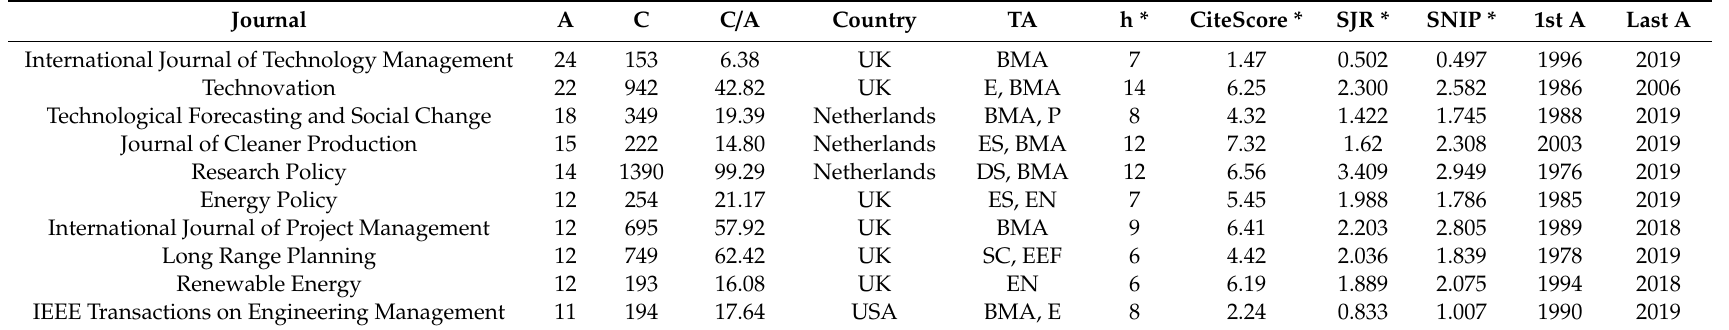
Table 3. Top 10 journals